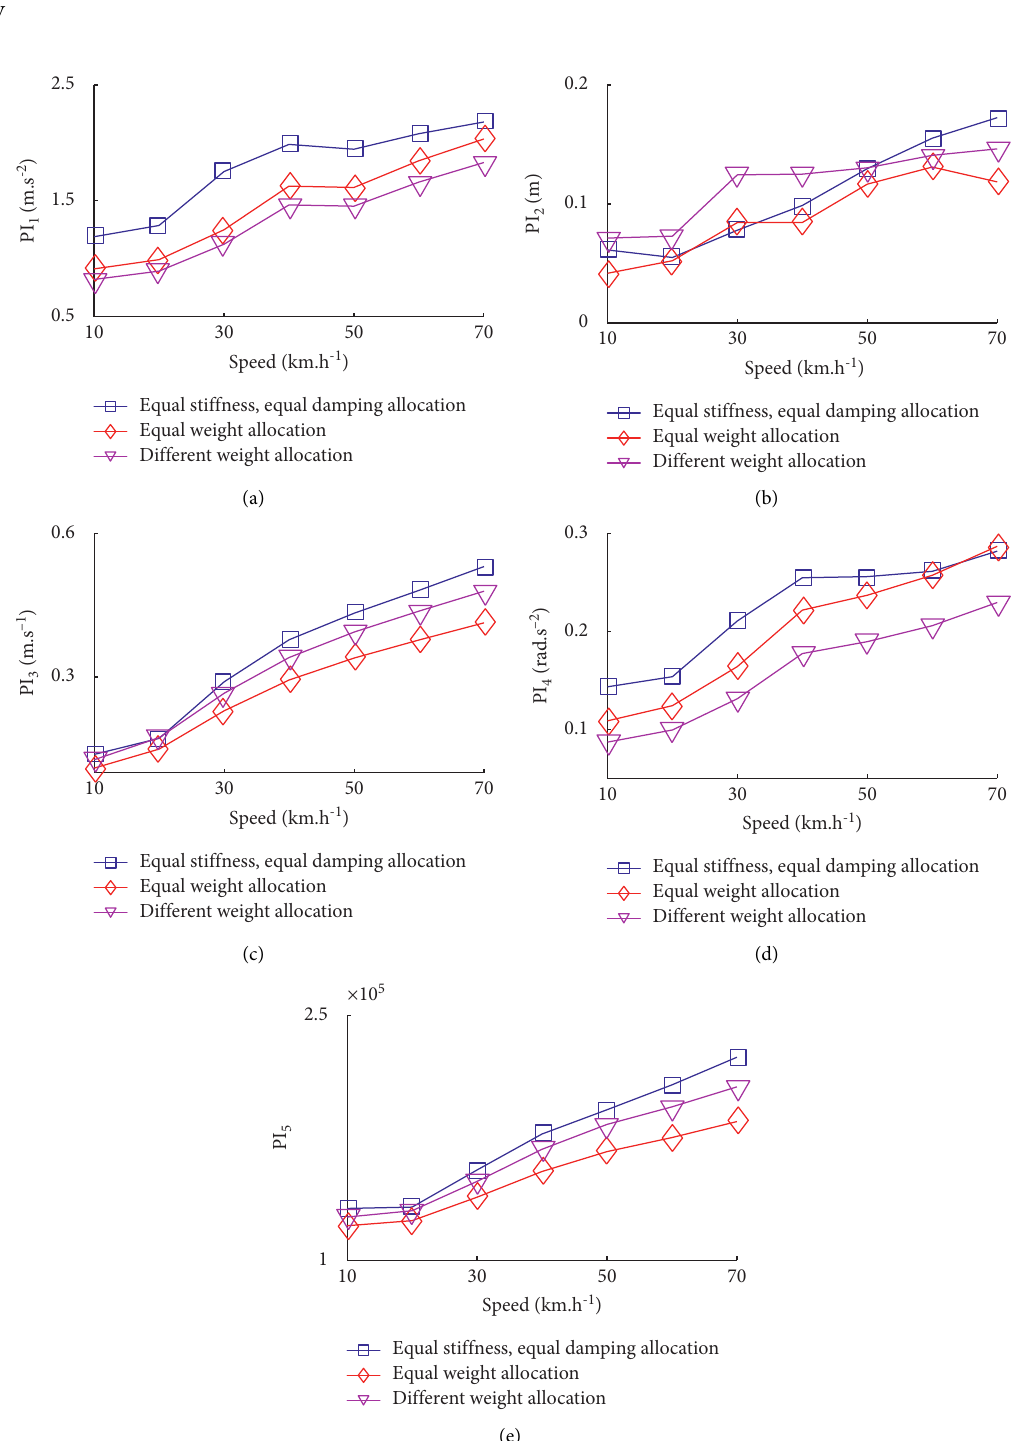
Figure 10: Comparison for the suspension system performance index (on paved